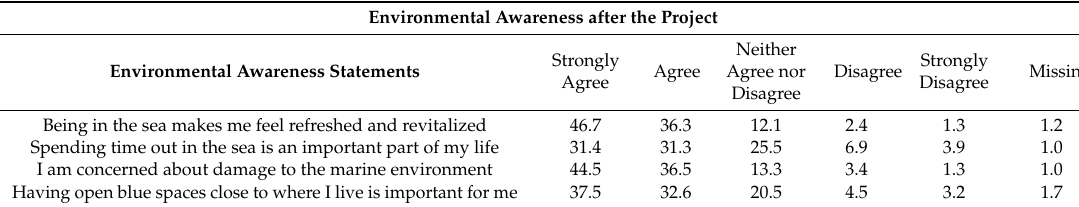
Table 12. Environmental awareness after the